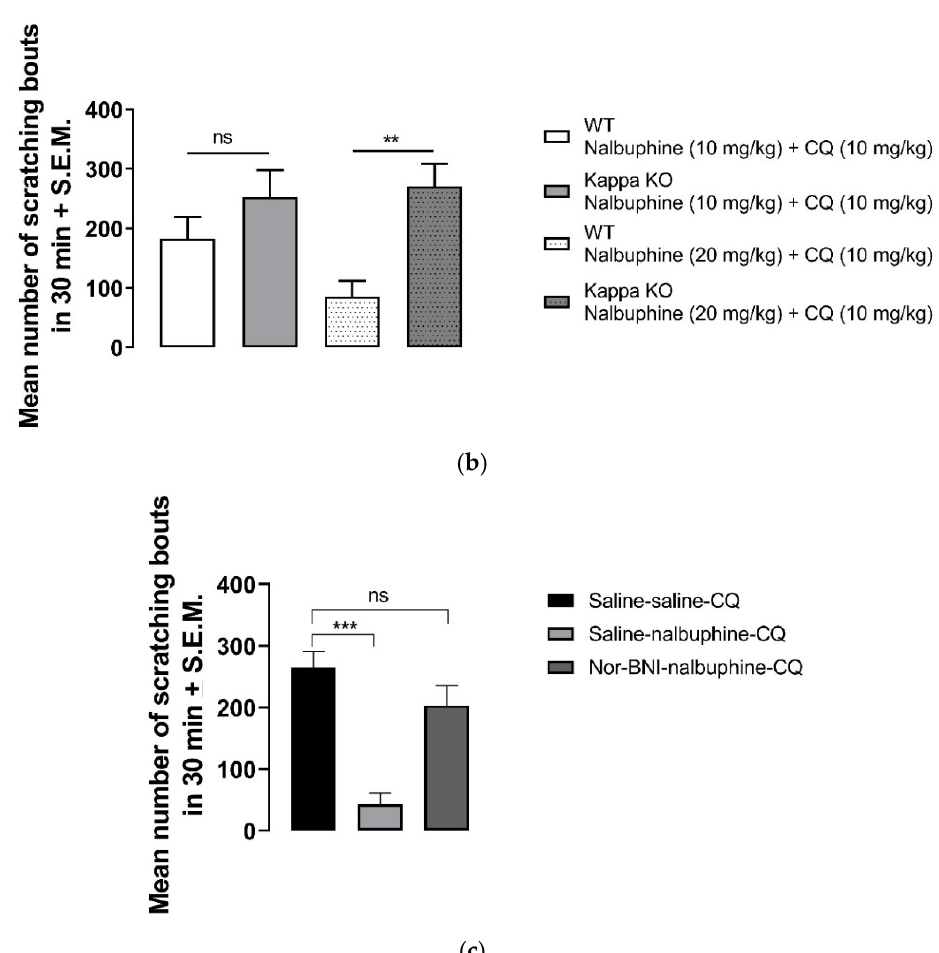
Figure 4. Nalbuphine significantly reduced CQ-induced scratching bouts in a dose-dependent manner. Panel ( a ) Swiss– Webster mice were injected with either saline or nalbuphine (1, 3, or 10 mg/kg). Thirty min later, they were administered a submaximal dose (10 mg/kg, s.c., behind the neck) of CQ. Then, the number of scratching bouts was counted for 30 min. Nalbuphine did not decrease scratching in KOR KO mice. Panel ( b ) Nalbuphine at 10 mg/kg did not have significant effect in C57BL/6J WT mice as in Swiss–Webster. Nalbuphine at 20 mg/kg significantly reduced scratching induced by CQ in WT mice, but not in KOR KO mice. Nalbuphine had no antiscratch effect in Swiss–Webster mice pretreated with nor-BNI. Panel ( c ) Mice were administered with nor-BNI or saline 20 h before the nalbuphine injection. Then, mice received either saline or nalbuphine. Thirty min later, they were injected with CQ. Nalbuphine significantly reduced scratching in mice pretreated with saline the day before; however, no significant effect was observed in mice pretreated with nor-BNI. (one- way ANOVA followed by Dunnett’s multiple comparison; * p < 0.05, ** p < 0.01, *** p < 0.001, **** p < 0.0001; n =